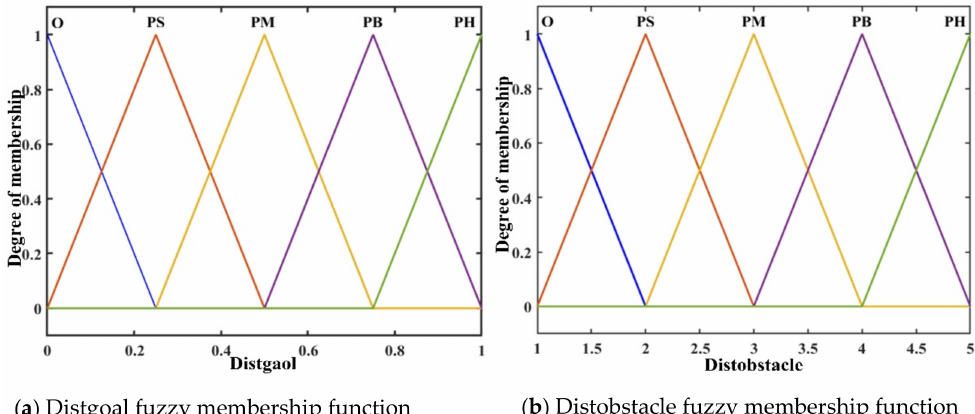
Figure 10. Fuzzy input membership functions.